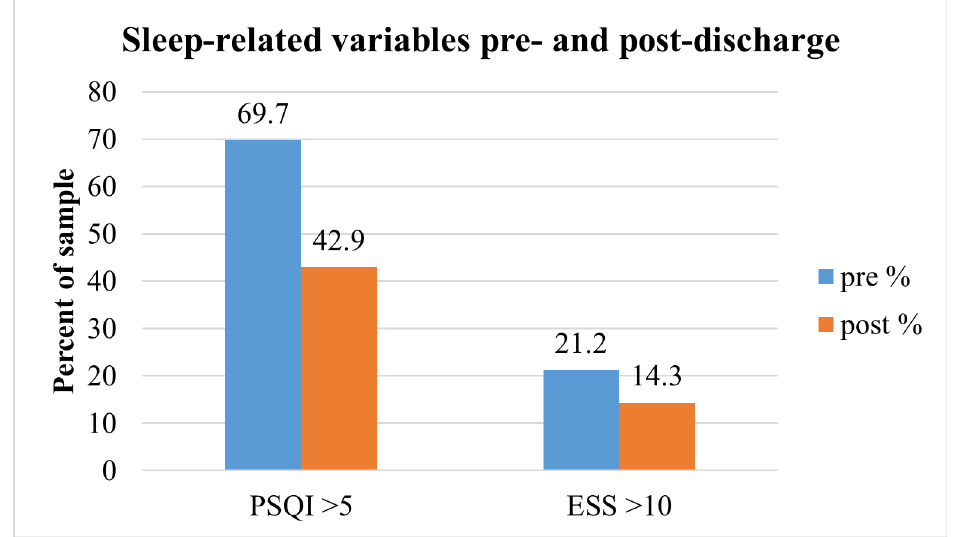
(change in distribution of PSQI scores).